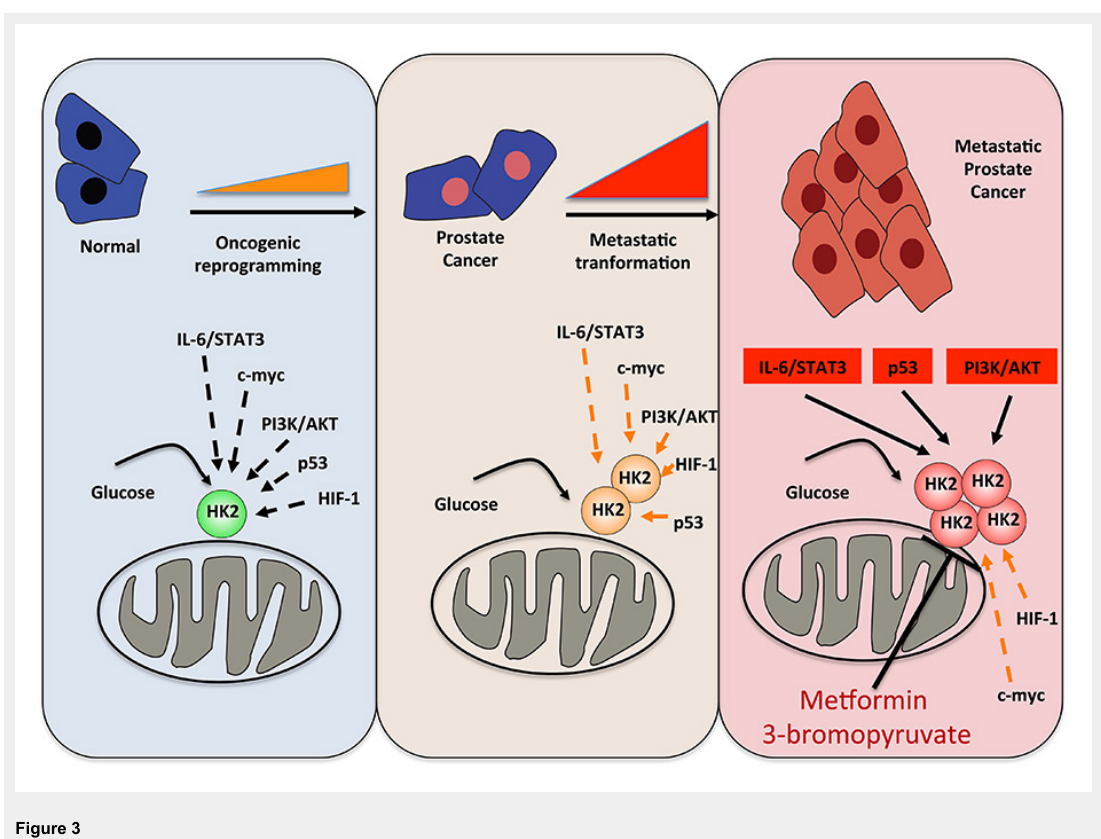
Figure 3 Targeting IL-6/STAT3-p53-PI3K/AKT signalling inducing metastatic prostate cancer metabolism by HK2 inhibitors (metformin or